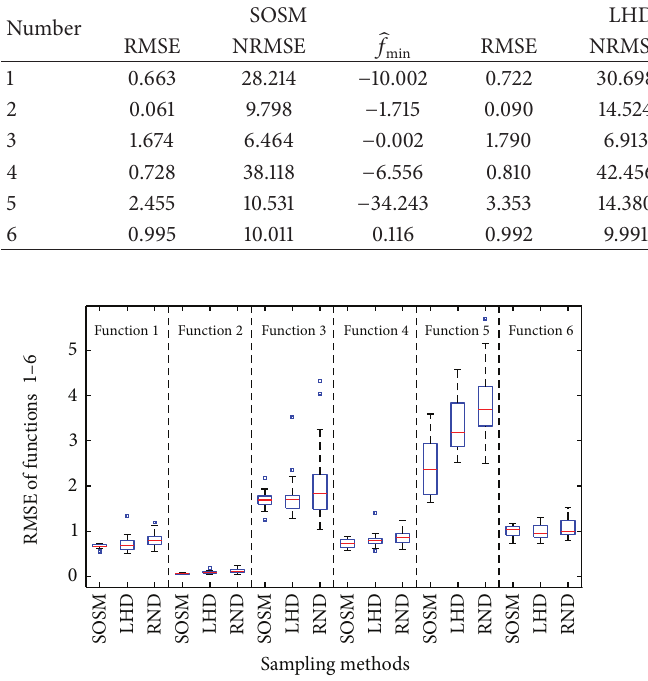
Figure 8: Assessment of metamodels: NRMSE between SOSM and one-stage sampling methods.